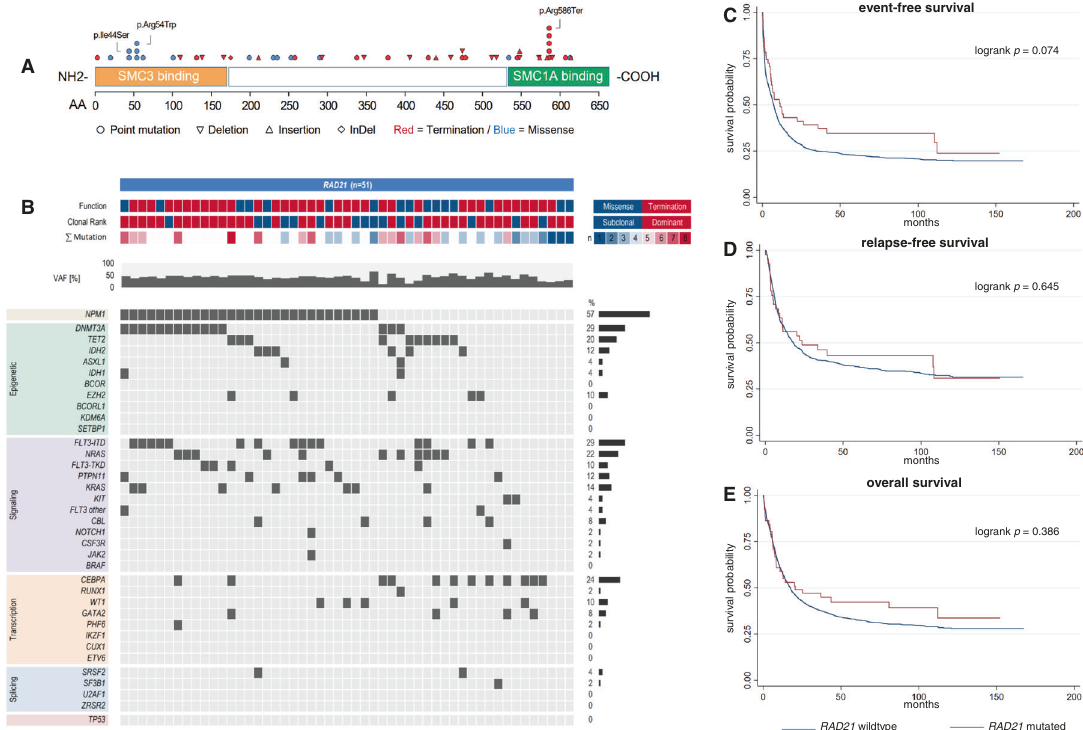
Fig. 2 Distribution, co-mutational spectrum and survival analysis for AML with mutated RAD21 . Graphic representation of the domain structure of RAD21 and positions of RAD21 mutations in 51 AML patients ( A ). Mutations of RAD21 are categorized by function (missense = blue, termination = red), clonal rank (dominant = red/subclonal = blue), number of mutations, and variant allele fraction, and associated co-mutations ( B ). For detailed information on co-mutations and results of individual signi fi cance tests, see Tab. S10. Survival analysis using the Kaplan-Meier method and logrank test for event-free ( C ), relapse-free ( D ) and overall survival ( E ) differentiating between RAD21 -mutated and RAD21 -wildtype